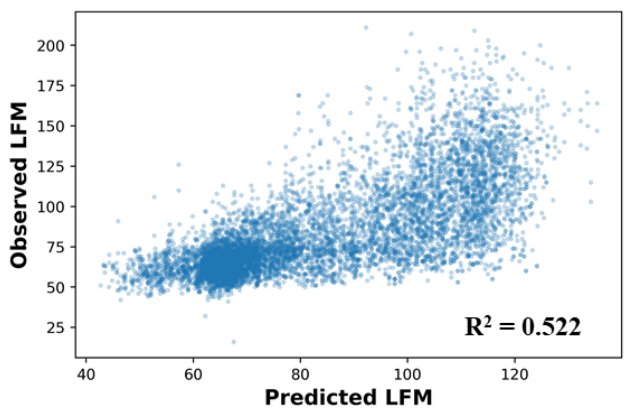
Figure A2. LFM of ( a ) predicted LFM v. cumulative burned area, and ( b ) predicted LFM vs. cumulative number of fires. Breakpoints were calculated based solely on the observed mean LFM within the recorded wildfire perimeters, and were not adjusted to correct for the variable frequency of LFM over space or time.